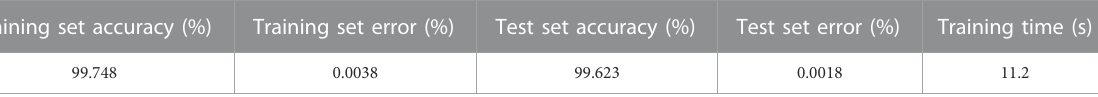
TABLE 2 Training results of CNN.